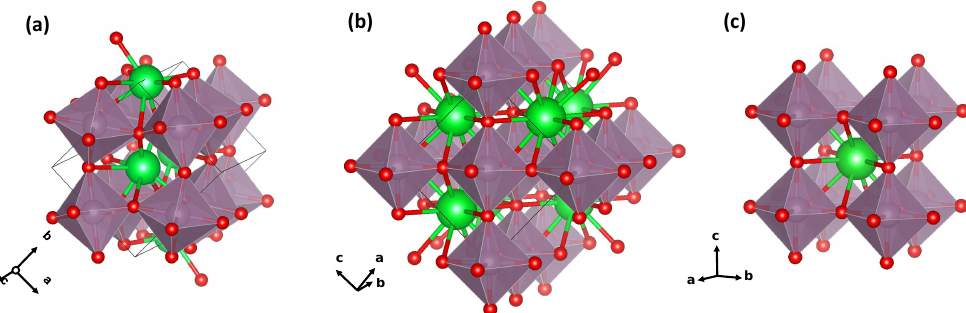
Figure 1. Crystal structures of ( a ) CaMoO 3 , ( b ) SrMoO 3 (at temperatures below 125 K), and ( c ) BaMoO 3 . The conventional crystallographic axes have been rotated to emphasize the similarity of the structures, which consist of a network of corner-shared [MoO 6 ]